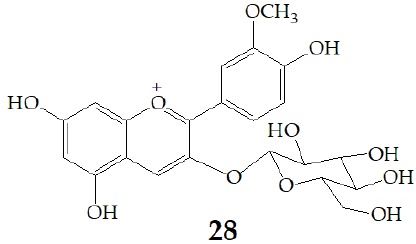
Figure 8. Chemical structures of compound 28 .